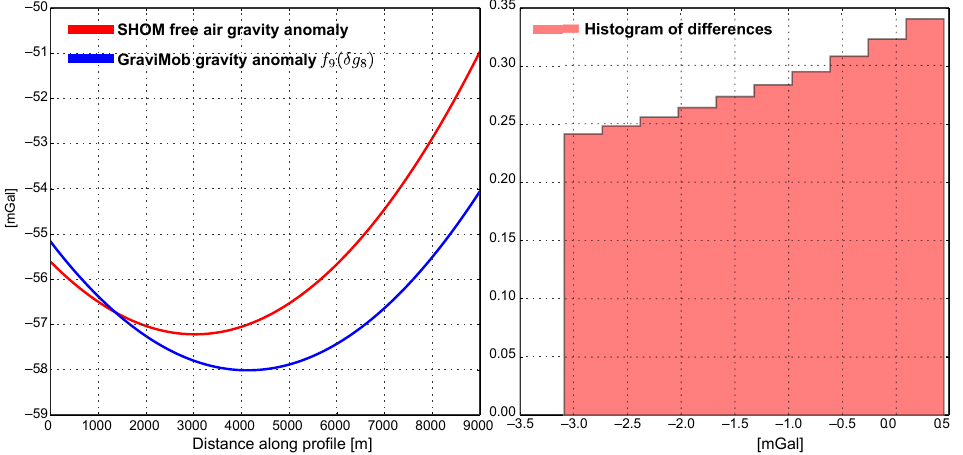
Figure 16. Left-hand plot: variations of the surface gravity anomaly deduced from that measured on route 8 ( δ g 8 ) by upward continuation using transfer function f 9 . The SHOM anomaly is represented by the red solid curve. Right-hand plot: histogram of the differences between the two anomalies at each measured point of the